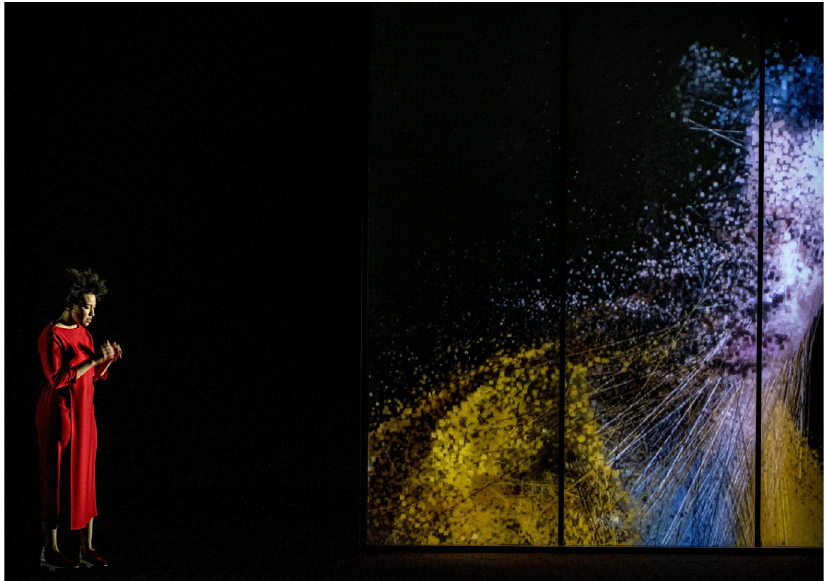
Fig. 8 – Julia Bullock and Roderick Williams in Michel van der Aa’s Upload , Dutch National Opera. Photo credit: Marco